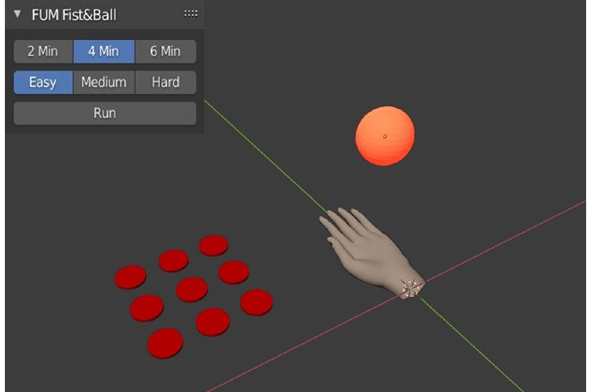
Figure 5. Simulation environment of Fist and Ball. It consists of nine red plates as LEDs of the electronic Myo, a 3D model as a hand, and the orange plate as a ball. The left upper panel shows the control panel of the Fist and Ball environment with three exercise durations and difficulty